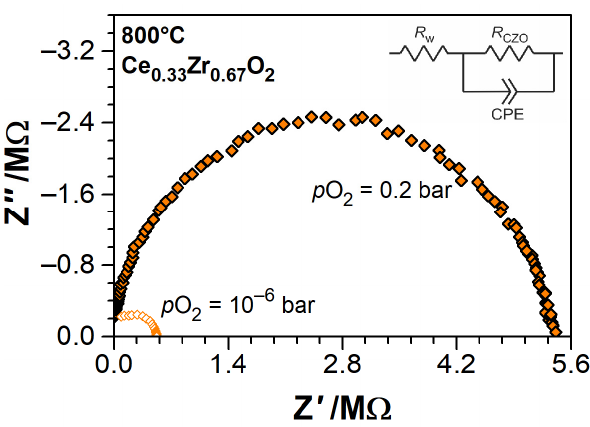
Figure 2. Typical impedance spectra of Ce 1 − x Zr x O 2 thin films in lateral measurement configuration and a corresponding equivalent circuit with R w being the negligible resistance of lead wires and R CZO standing for the resistance of the Ce 1 − x Zr x O 2 − δ (CZO) thin films. Z’ and Z” are the real and imaginary parts of impedance, respectively.